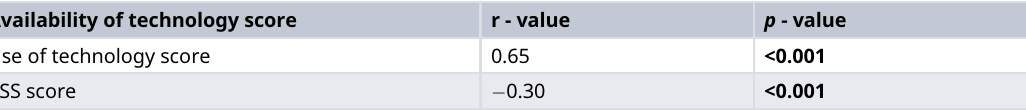
Table 3. Correlation between the scores of availability of technology, use of technology & perceived stress scale